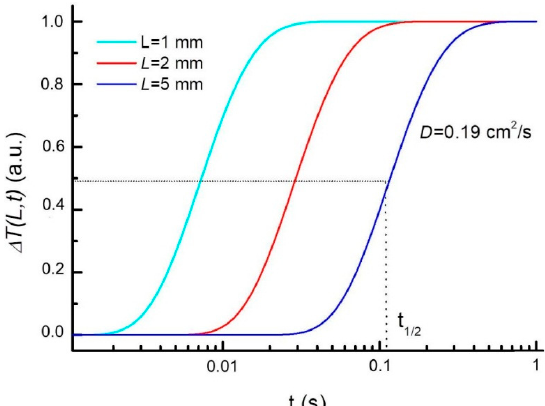
Figure 2. Semi-logarithmic plot of the normalized transient temperature rise ∆ T ( L,t ) vs. time calculated for the same L and D values of Figure 1.